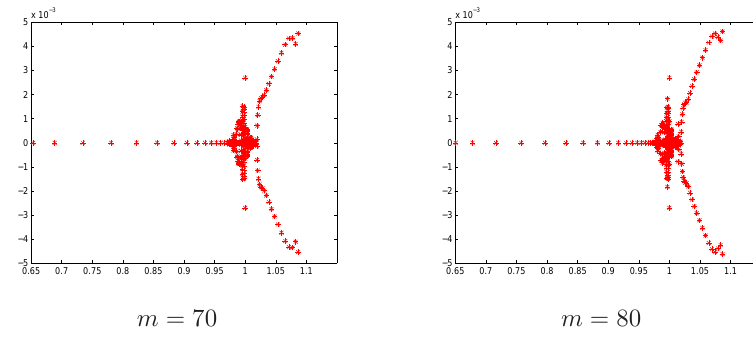
Figure 4. The spectrum of the preconditioned matrix M − 1 A for m = 70 and m =